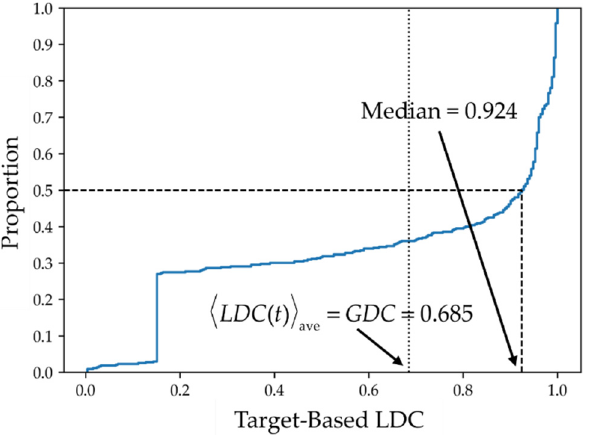
Figure 8. Cumulative distribution of target-based local data completeness, LDC ( t ) . The cumulative distribution of the target data completeness of all 433 ligands is shown.